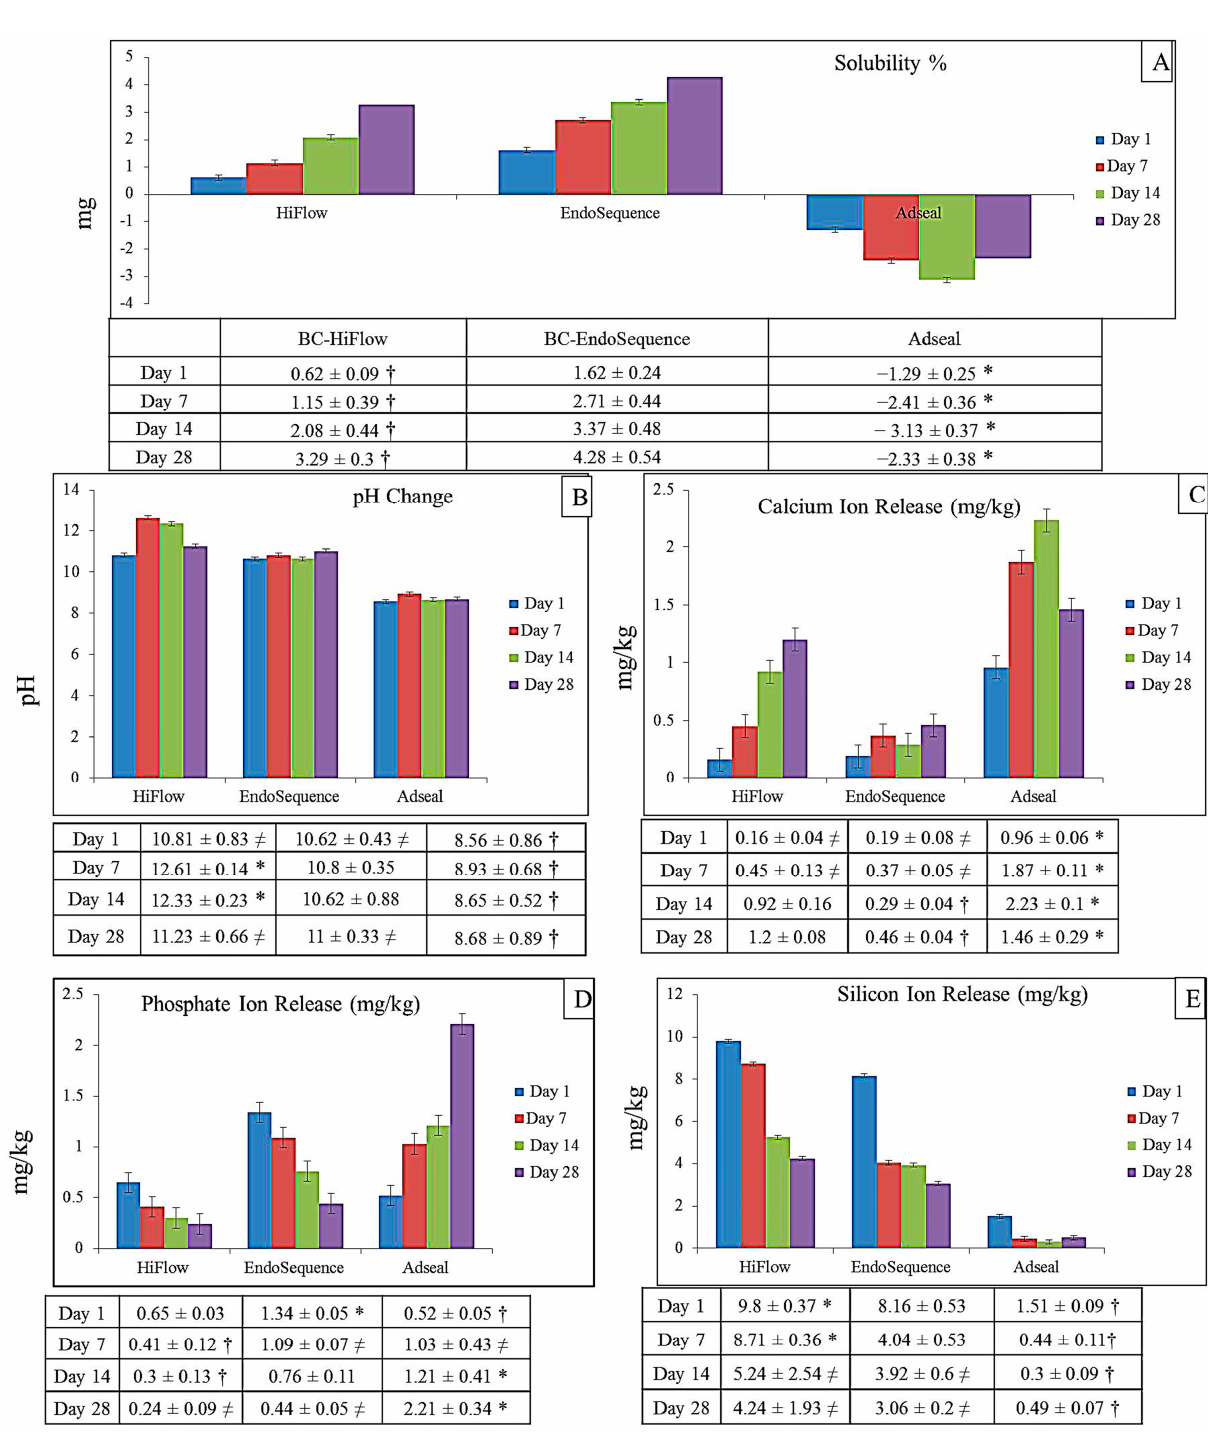
Figure 1. Represents the mean ± standard deviation values of ( A ) solubility %, ( B ) pH changes, ( C ) calcium, ( D ) phosphate and ( E ) silicon ions released of the investigated sealers among the experiment immersion times. ( * ) is the significant greatest value while ( † ) is the significant lowest value at p < 0.001. ( ≠ ) indicates no significant difference between the sealers of the same symbol at p > 0.05.